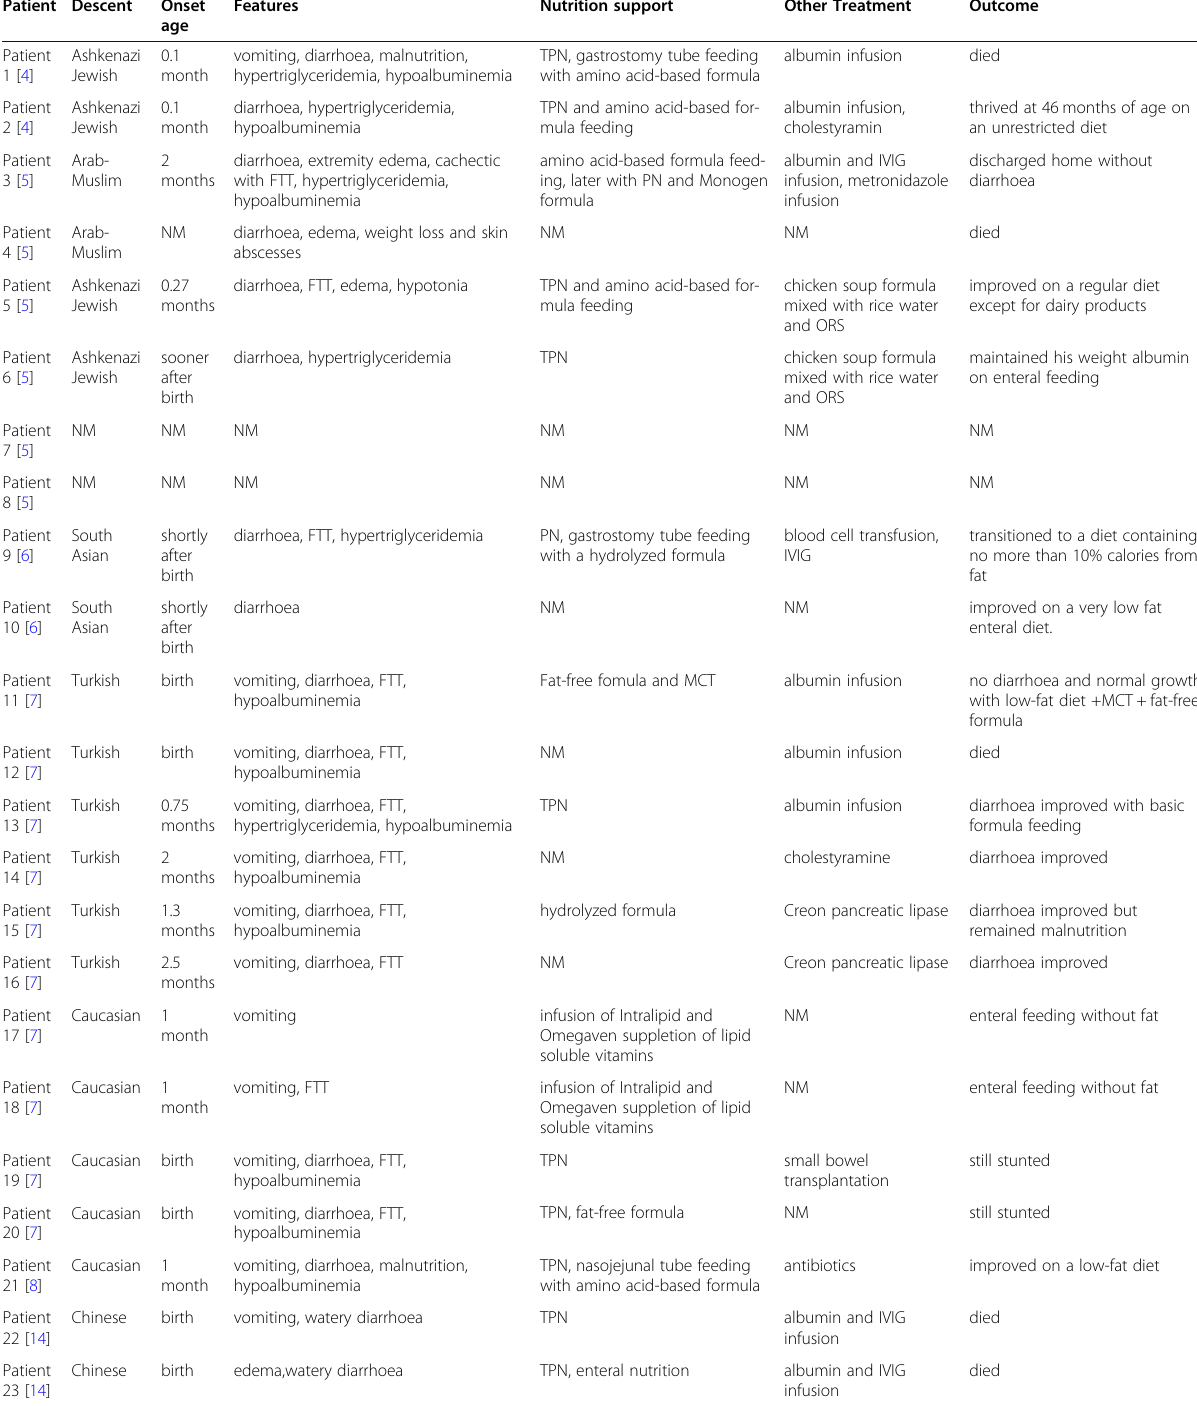
Table 1 Characteristics of published DGAT1 deficiency patients Patient Descent Onset